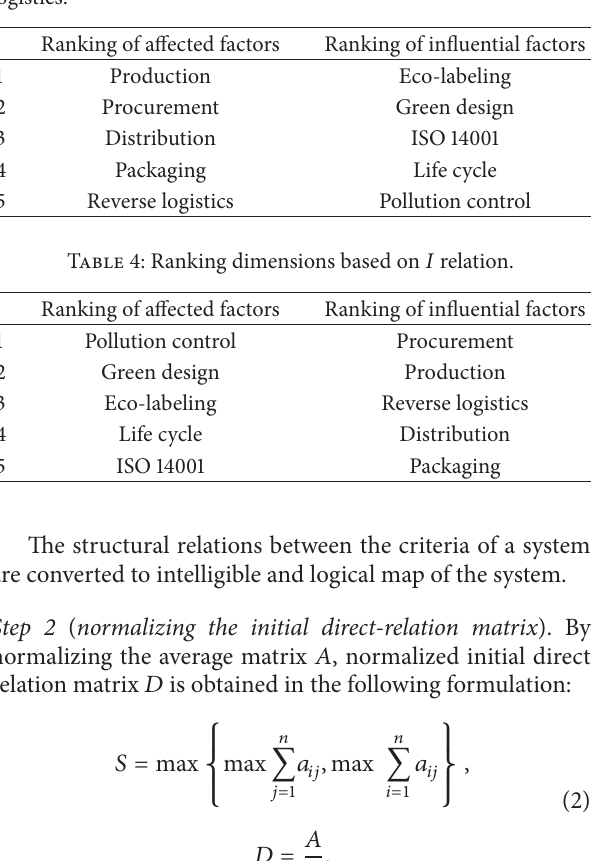
Table 3: Ranking dimensions: environmental protection on green logistics.